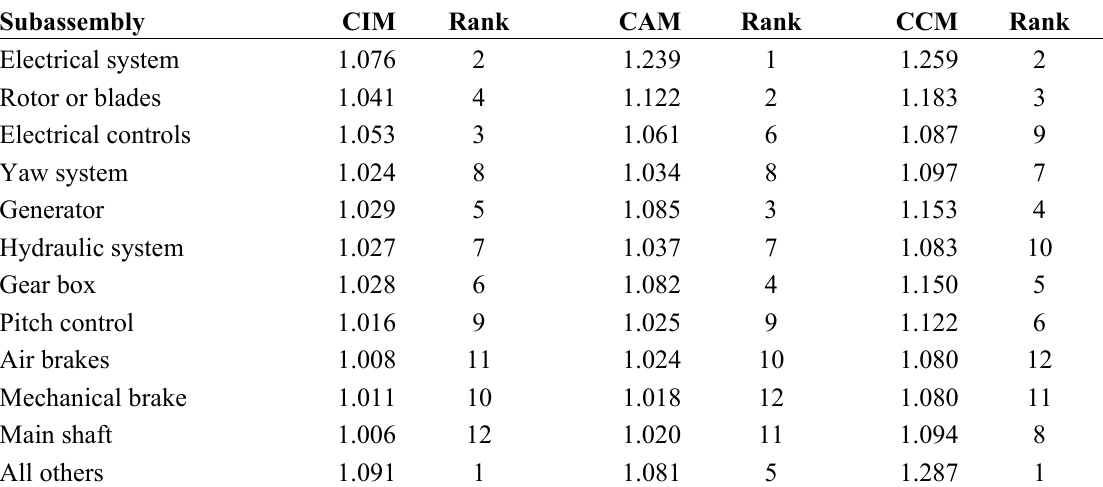
Table 2. Subassembly importance measures and